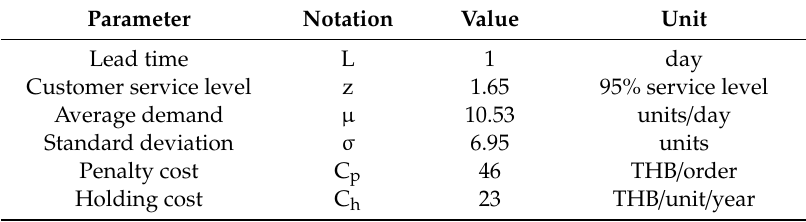
Table 3. Model parameters of inventory management with (s, S) policy.